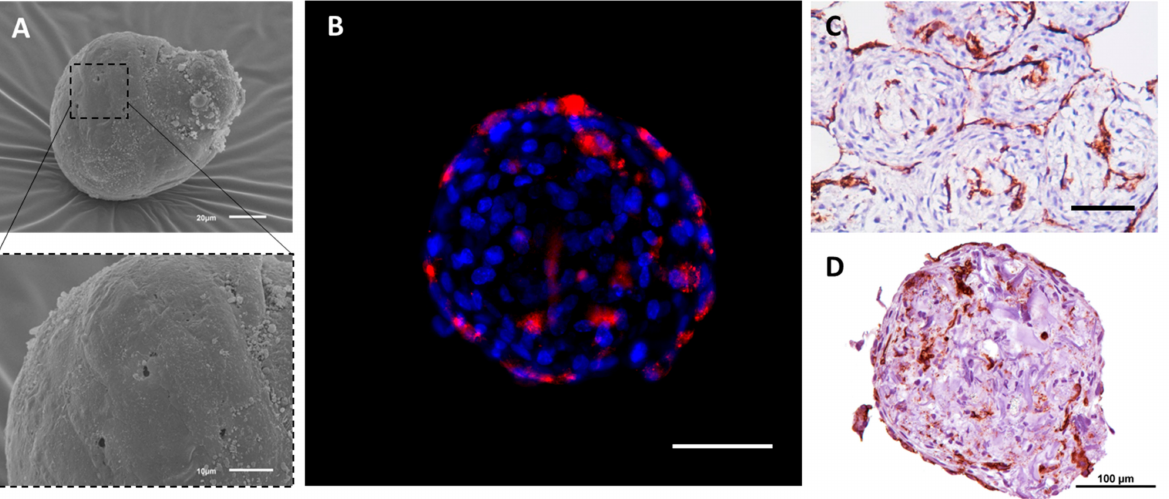
Figure 2. The structure and internal organization of heterotypic tissue spheroids that are assembled of HUVECs and human umbilical cord MSCs (UCMSCs). The formation of the spheroids: the suspension of cells (100 µ L per well, 1000 cells per spheroid, 1:1 ratio) was added to the non-adhesive U-bottom 96-well plate (Corning, Corning, NY, USA). After 72 h, the spheroids were collected and studied using scanning electron microscopy (SEM), immunofluorescence (IF), and immunohistochemistry (IHC). ( A ) SEM of the heterotypic HUVEC-UCMSC spheroids at day three in culture. The scale bars correspond to 20 µ m (top) and 10 µ m (bottom). ( B ) IF study of the formation of the 3D inner endothelial structures inside HUVEC-UCMSC spheroids. HUVECs were labeled with PKH26 (red, Sigma, USA) prior to tissue spheroids formation. The mixed tissue spheroids were incubated with DAPI (1:1000, Invitrogen, Waltham, MA, USA) to counterstain cell nuclei (blue). The scale bar corresponds to 100 µ m. ( C , D ) IHC staining of spheroids for CD31, a marker of HUVECs. Prior